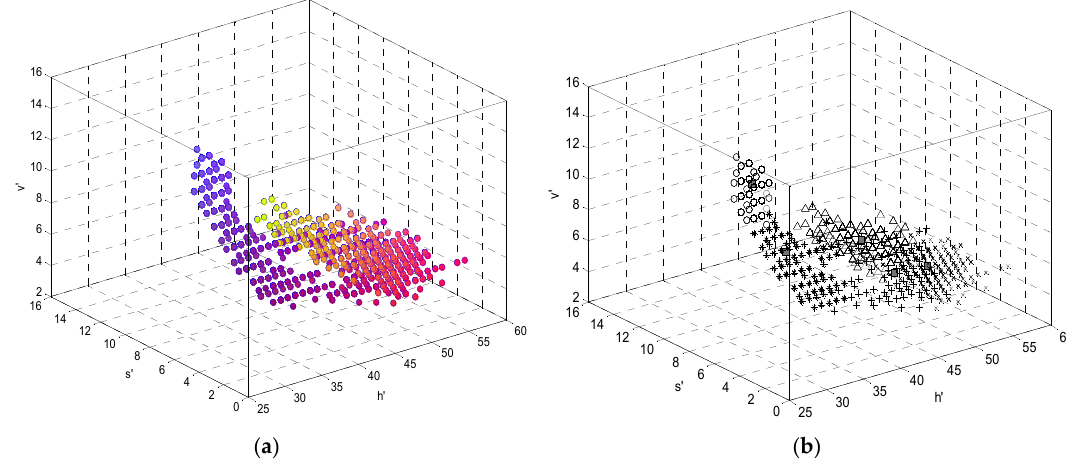
Figure 5. ( a ) Three-dimensional histogram of h 1 s 1 v 1 ; and ( b ) the result of FCM clustering. (cid:4) is the position of the clustering center and the other five symbols are five different clusterings.